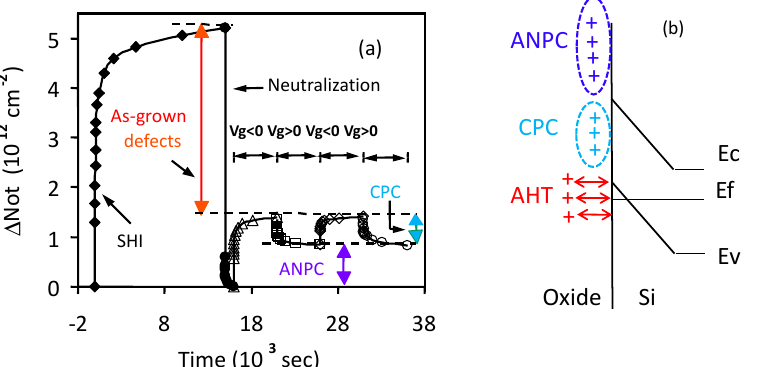
Figure 22. Different types of positive charges in a gate dielectric. ( a ) In addition to as-grown defects, some of the generated defects can be repeatedly charged and discharged by alternating the gate bias polarity, and they are called as cyclic positive charges (CPCs). The rest of generated positive charges are difficult to neutralize and are referred to as anti-neutralization positive charges (ANPCs). ( b ) The energy location of the different types of positive charges [49].